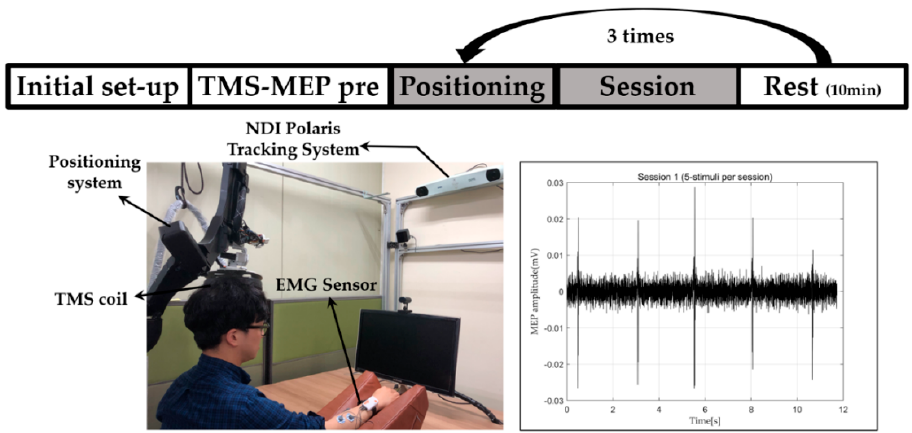
Figure 10. Procedure and setup of repeated response experiments of brain stimulation.